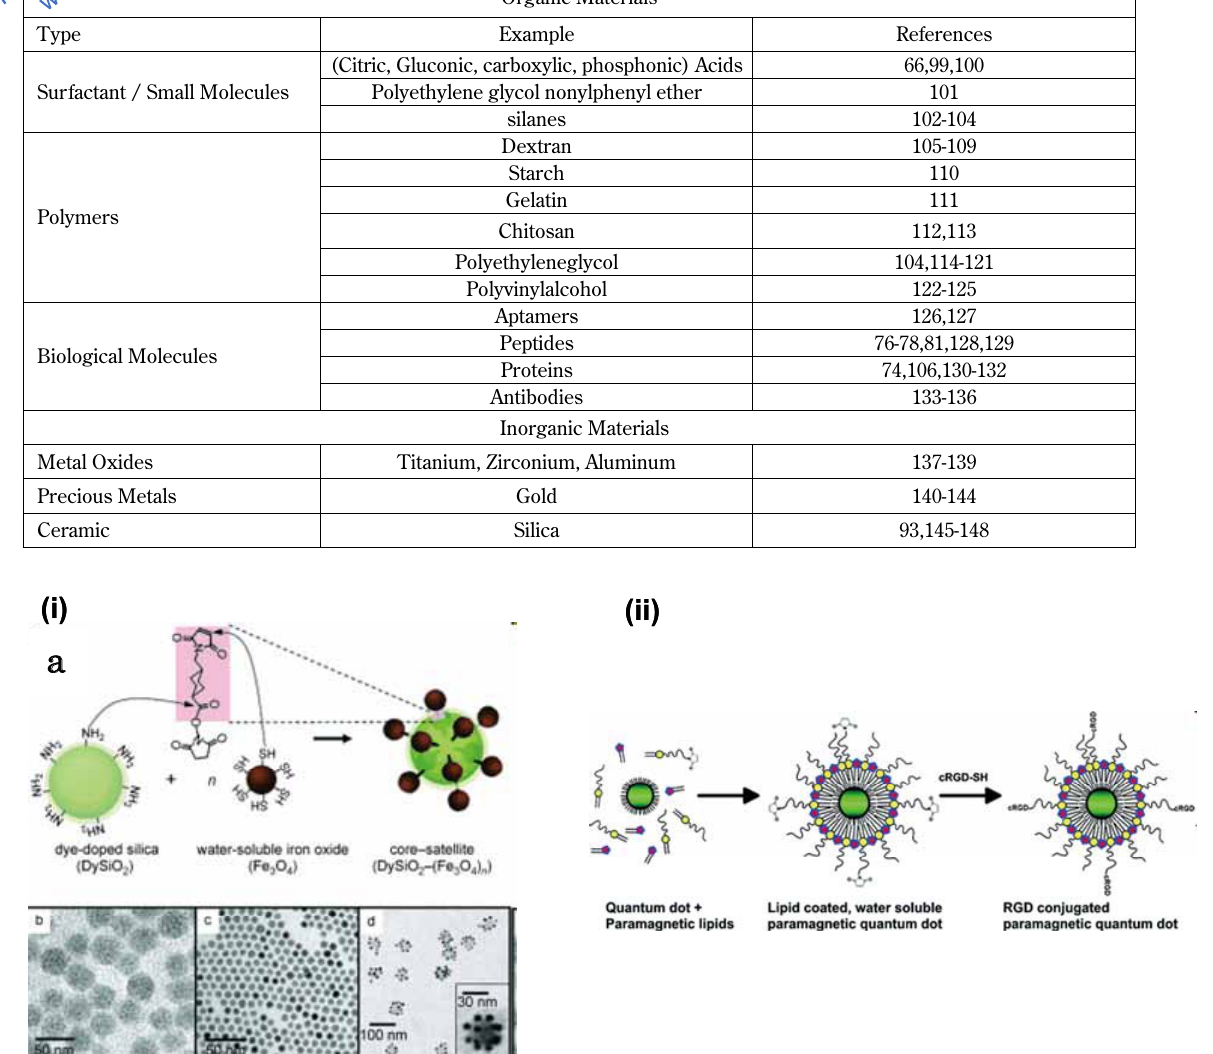
-(Fe O )n nanoparticles. b-d) TEM 2 3 4 O ), and d) core-satellite DySiO 3 4